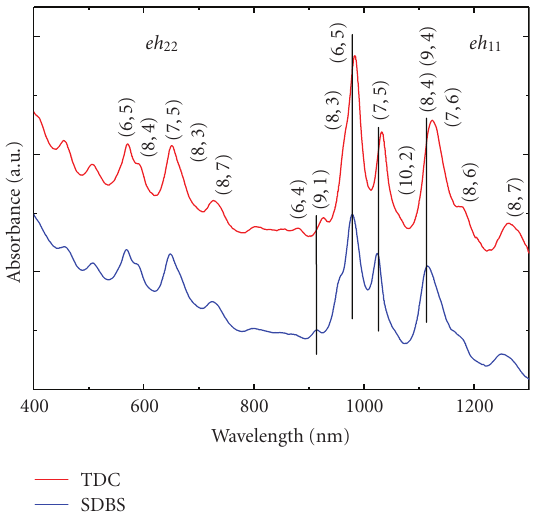
Figure 4: Optical absorption spectrum of CoMoCAT SWNTs dispersed in DI water using TDC (red line) and SDBS (blue line) as surfactant. The absorption peaks from di ff erent SWNT species are assigned according to [12, 33]. The shift in the peak positions and widths is due to di ff erent surfactants, which change the, dielectric environment. The vertical lines are intended to guide the eyes.